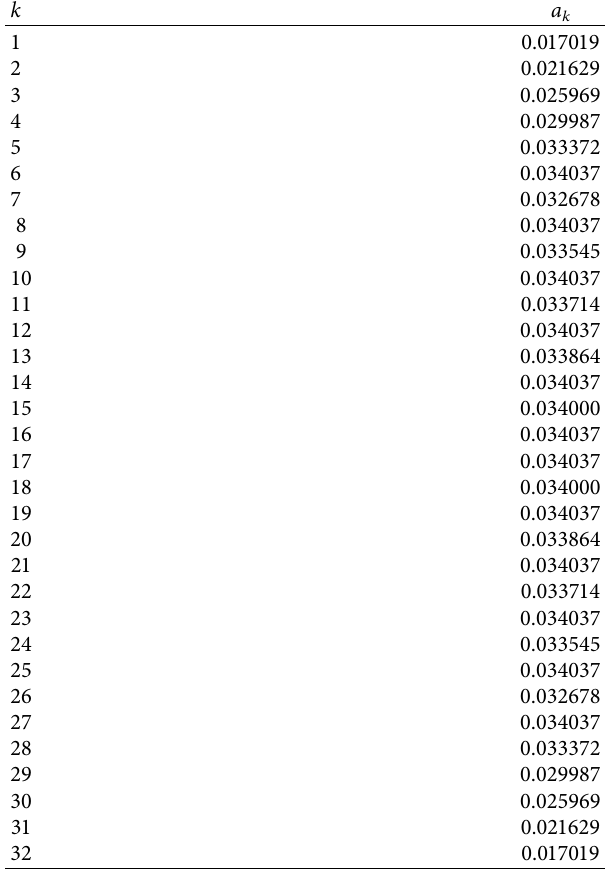
Table 10: Optimum coefcients of array with unequal element spacing obtained for D � 2.